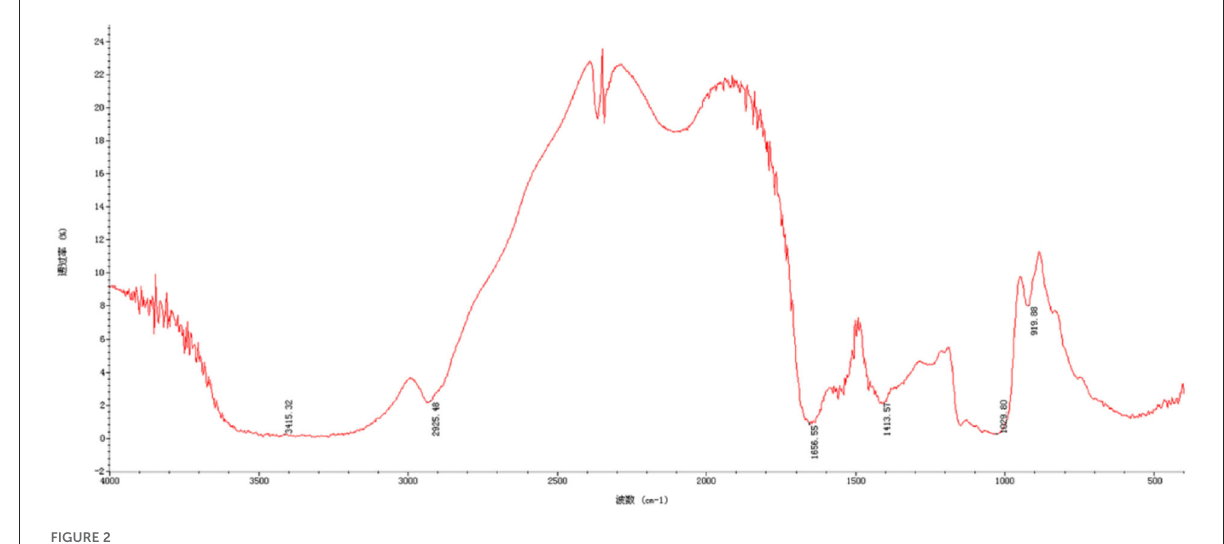
FIGURE2 Fourier-transform infrared (FT-IR) spectrum of